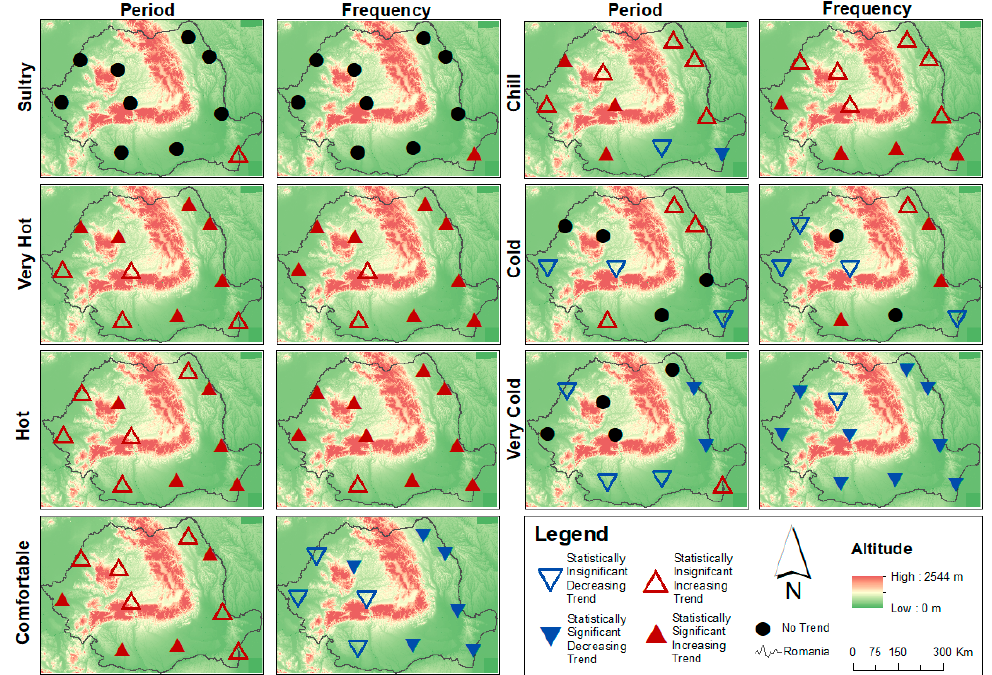
Figure 16. Spatial distribution of the trends detected for the THI index.